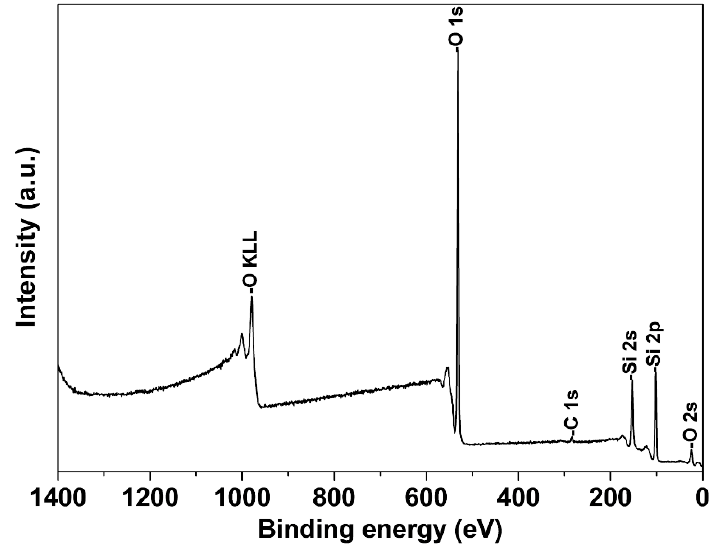
Figure 4. XPS spectra for pure MCM-41 M .